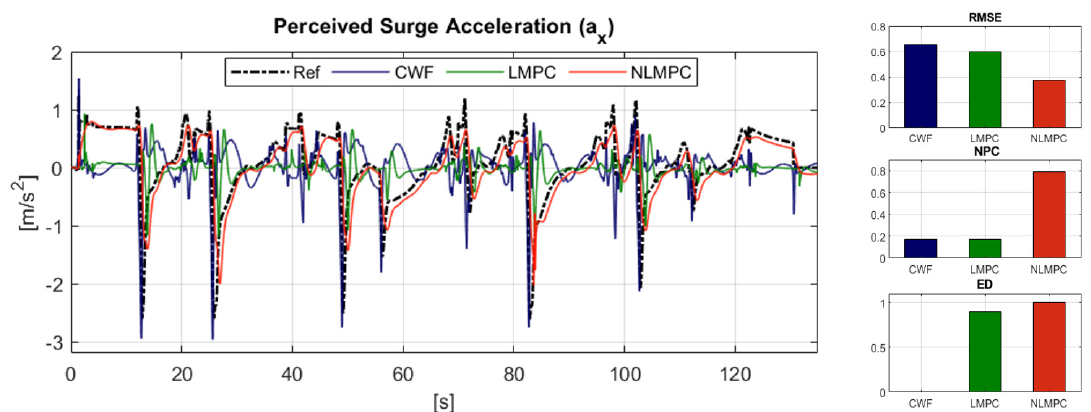
Figure 9. Reference Tracking performance: Perceived Surge Acceleration.